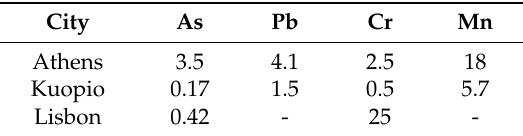
Table 4. Cumulative deposited dose (10 − 2 µ g) of particle-bound metals in the respiratory tract for an adult male at the end of one day